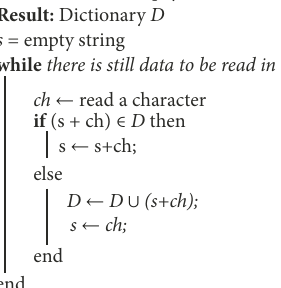
Figure 4: The algorithm for creating the dictionary D .